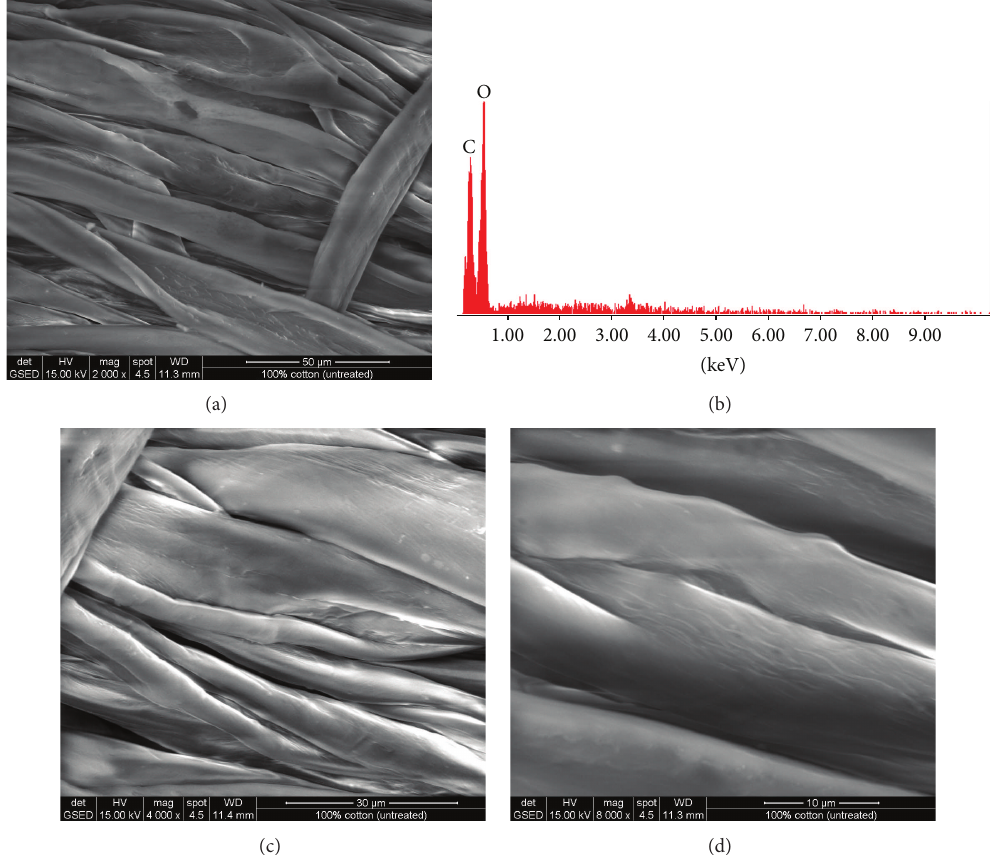
Figure 6: SEM and EDAX images for sample II (control) (plasma functionalized type II cotton 100%): (a) SEM image for sample II at resolution × 2000, (b) EDAX image for sample II, (c) SEM image for sample II at resolution × 4000, and (d) SEM image for sample II at resolution ×